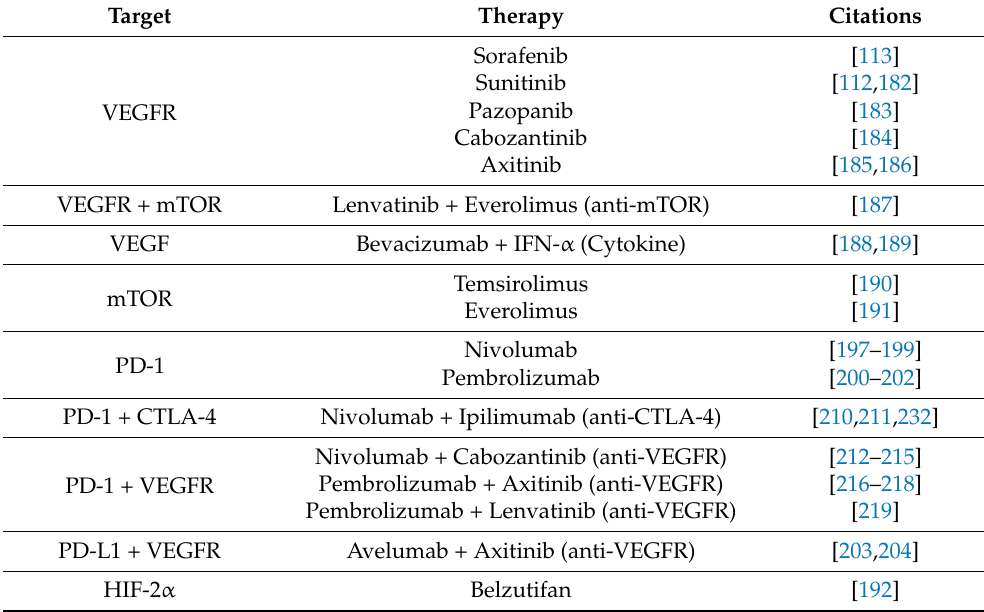
Table 1. List of FDA approved therapy to treat advanced renal cell carcinoma